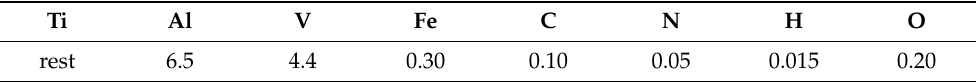
Table 1. Chemical composition of Ti-6Al-4V titanium alloy (mass